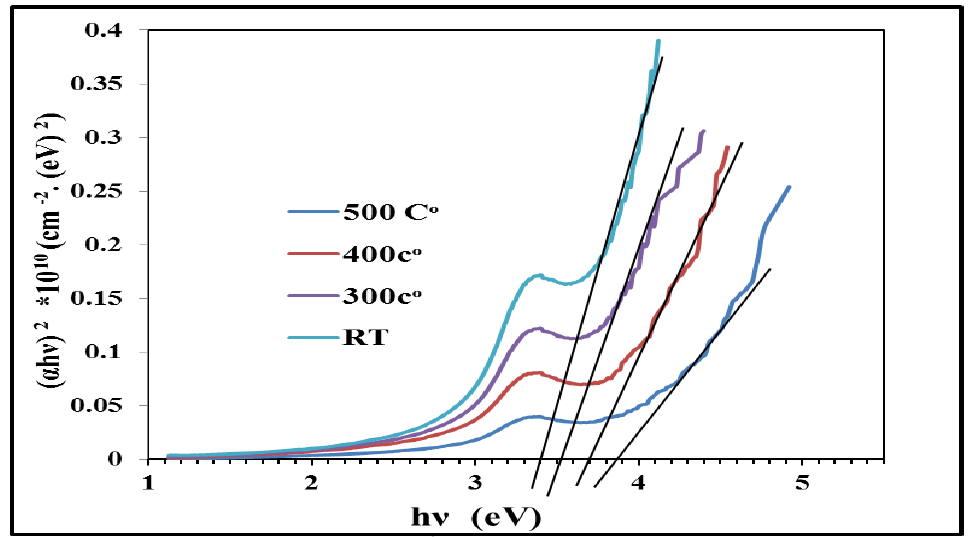
Fig. 7: Variation of the (αhυ) 2 vs. photon energy (hν) for Cr